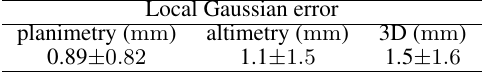
Table 6. Statistics of the residuals on